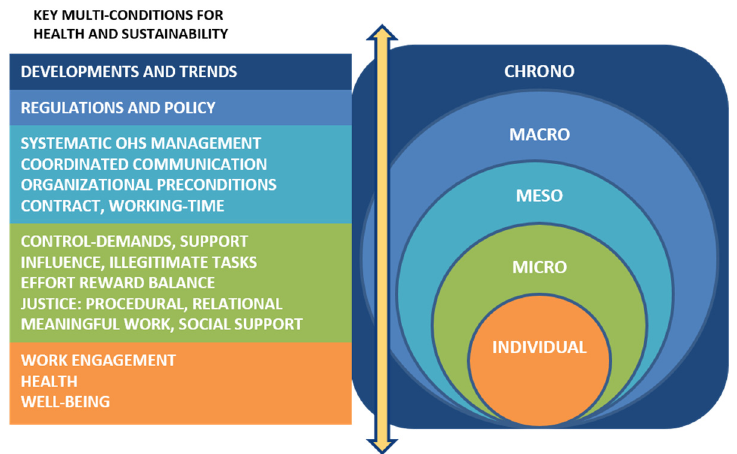
Figure 1. Examples of aspects on the different system levels included in the study. The arrow indicates the interplay between the levels (modified from [35]).